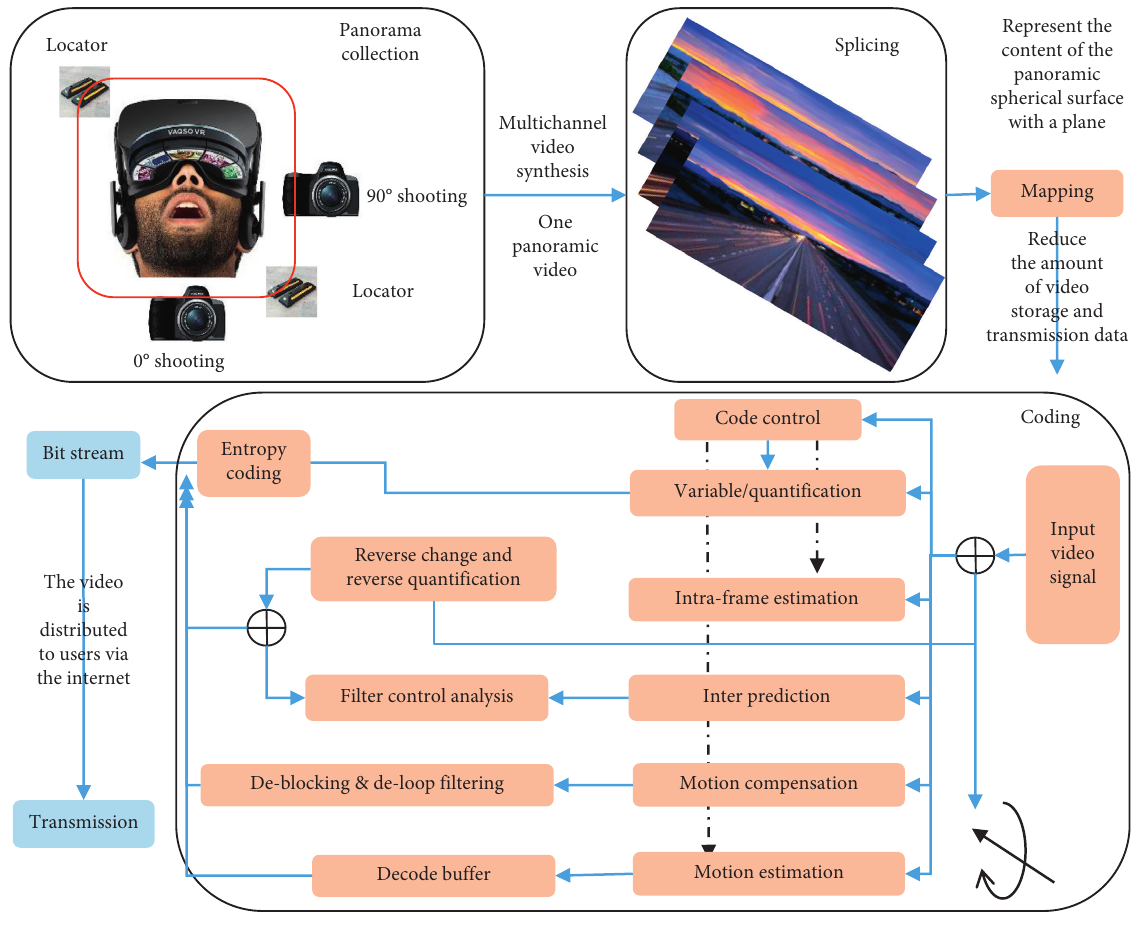
Figure 1: Virtual reality video transmission